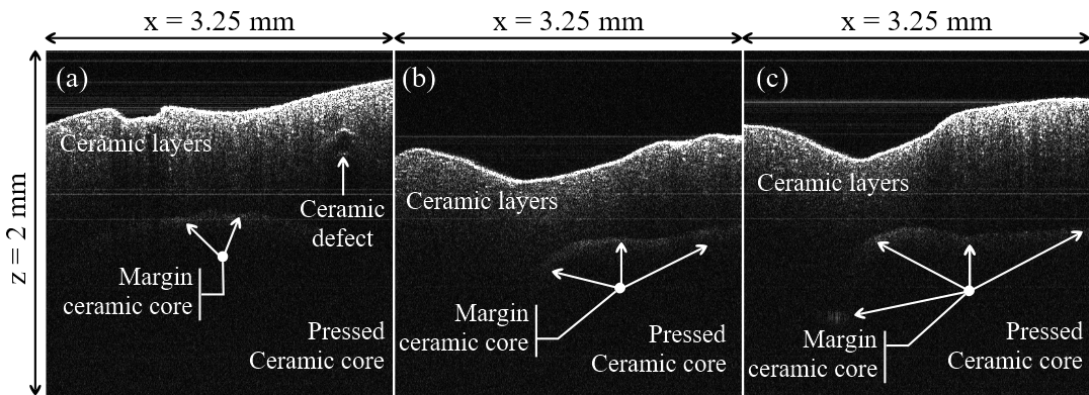
Figure 5. Examples of OCT B-scans/cross-sections of samples from the three groups considered in the study: ( a ) Group L; ( b ), Group N; ( c ) Group H. Material defects and margins of the pressed ceramic core can be remarked.